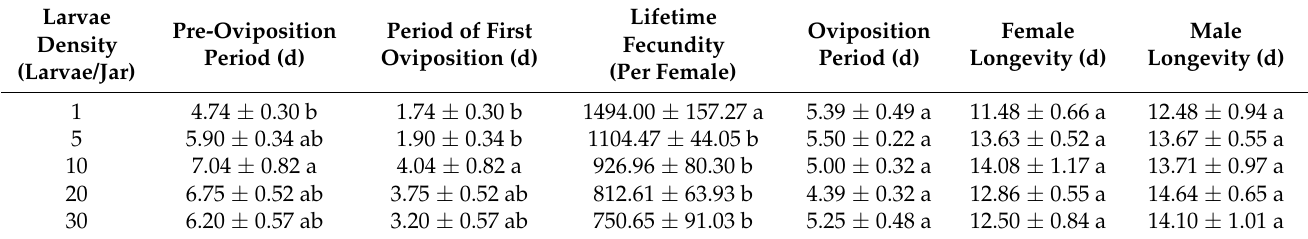
Table 2. Reproductive performances of Spodoptera frugiperda adults under different larval densities.